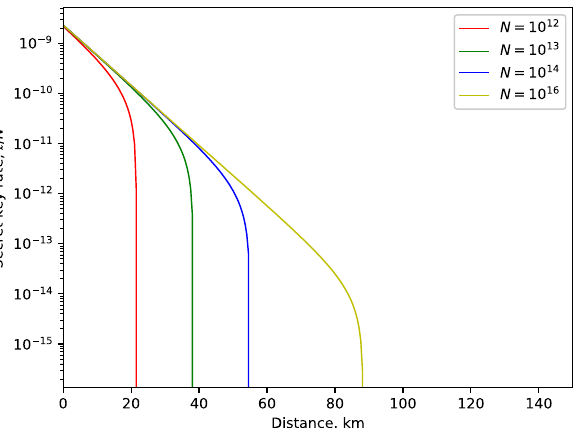
Figure 4. Illustration of the secret key rate (in logarithmic scale) in terms of the transmission distance (km), for a fixed amount of signals N